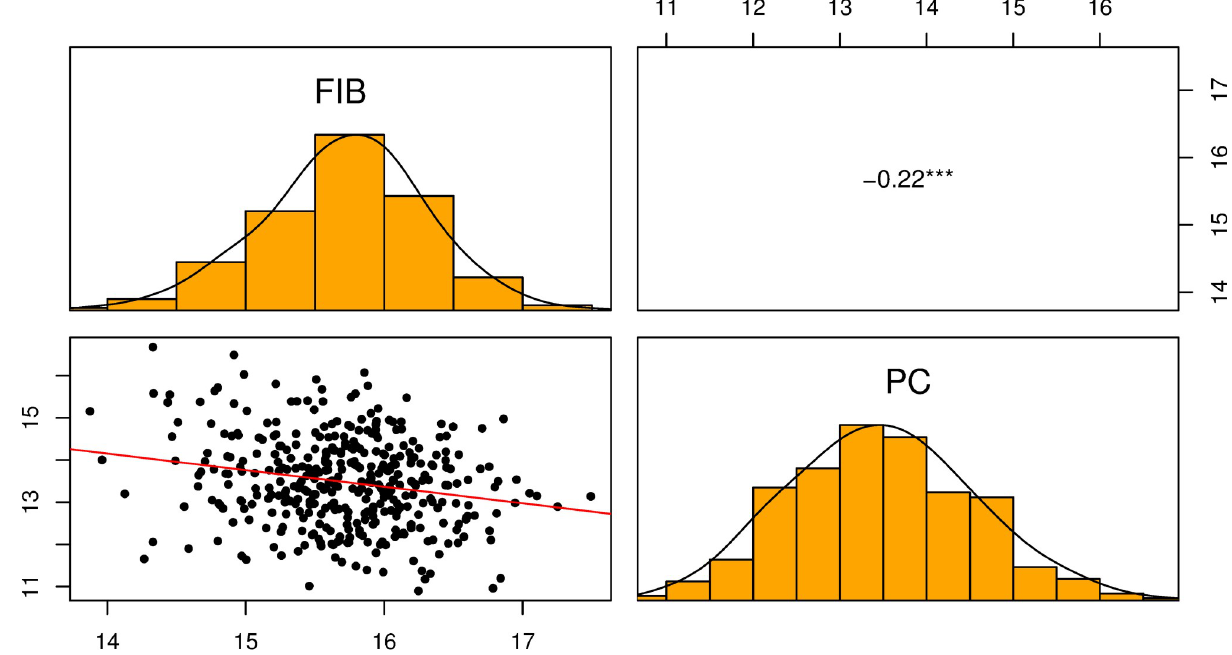
Fig 3. Scatter plot, histogram, and correlation of BLUPs of FIB and PC for 385 sugarcane clones.